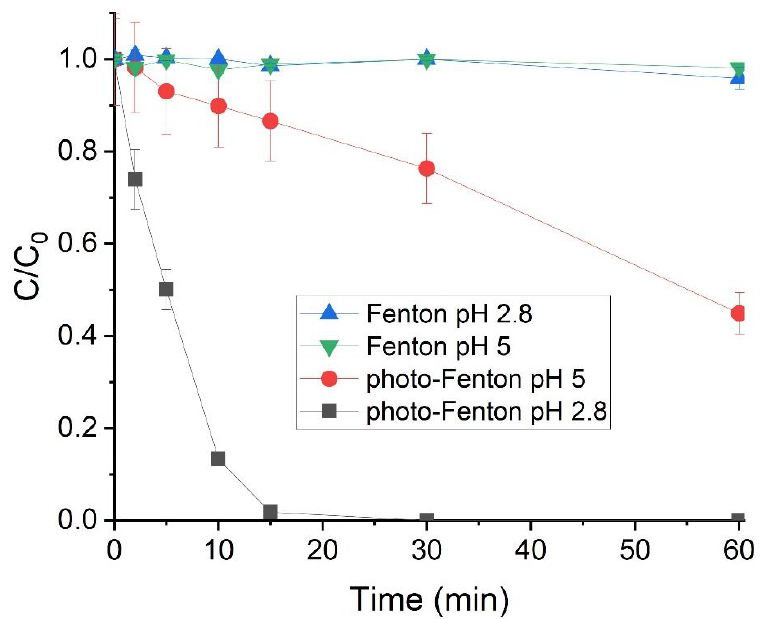
Figure 3. MIT degradation by Fenton and photo-Fenton processes at pH 2.8. and at pH 5. [Fe (III)] = 5 mg·L −1 , [H 2 O 2 ] = 5 mg·L −1 (stoichiometric), [MIT] = 5 mg·L −1 . [Fe (III)] = 5 mg · L − 1 , [H · L − 1 (stoichiometric), [MIT] = 5 mg · L − 1 2 O 2 ] = 5 mg